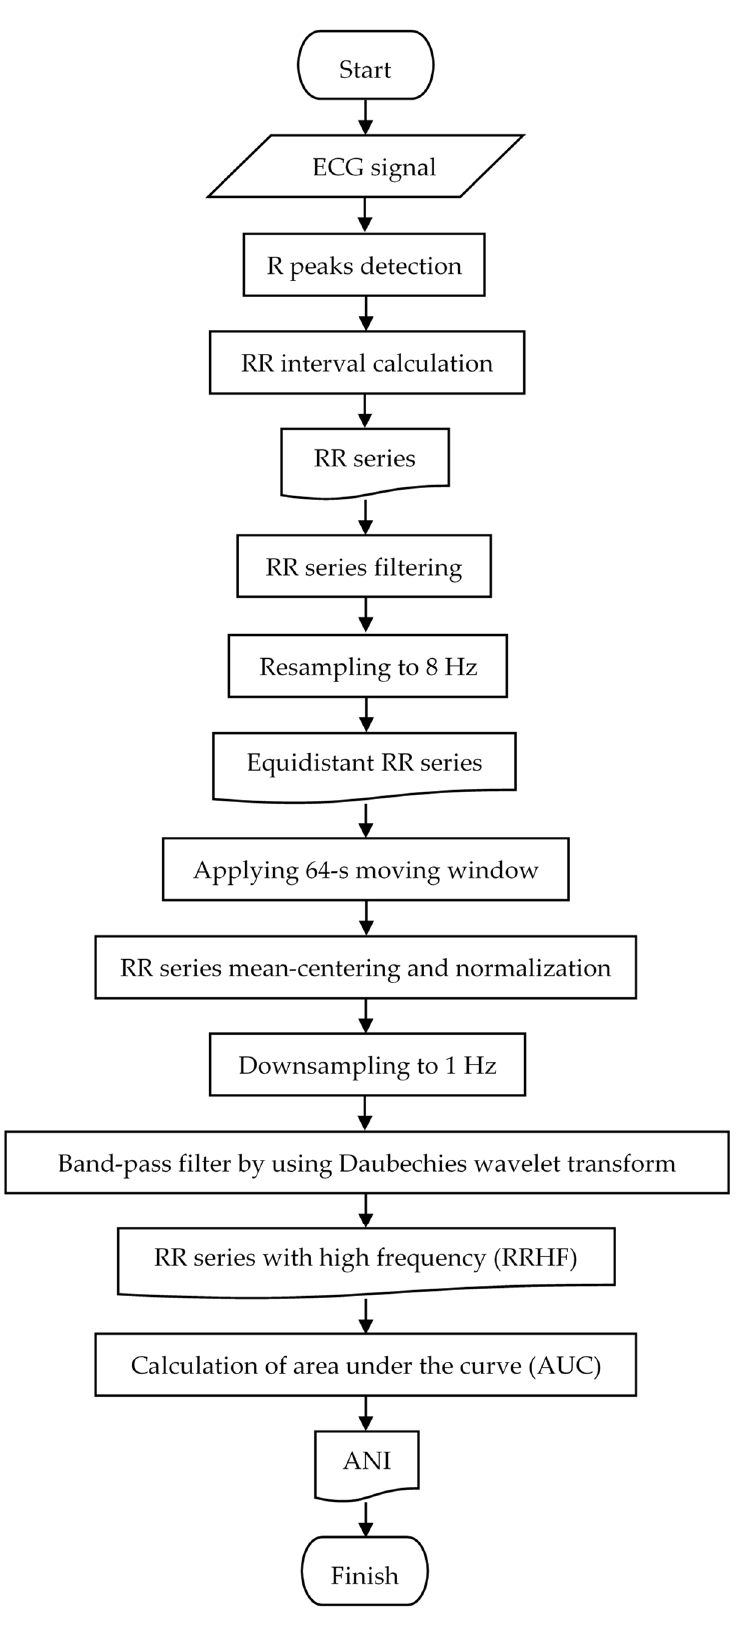
Figure 1. Flowchart of the ANI calculations.